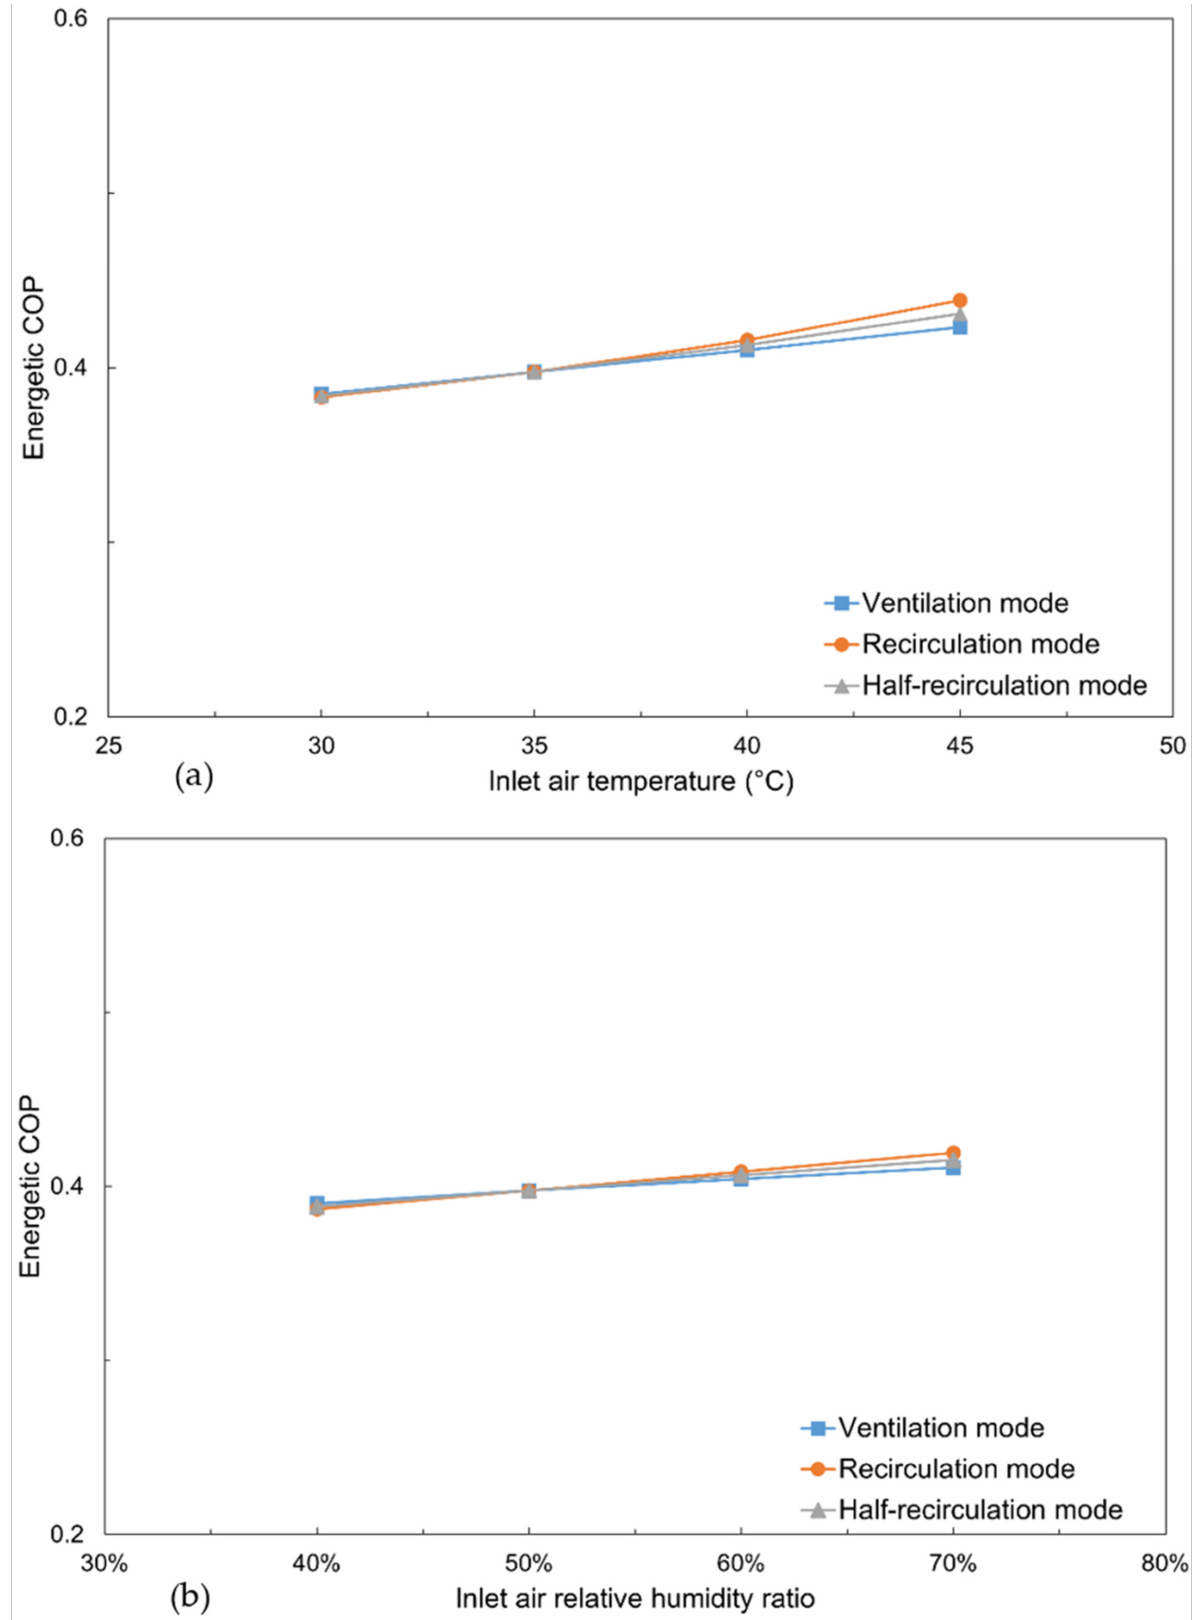
Figure 11. Effects of ( a ) ambient temperature and ( b ) humidity ratio on energetic